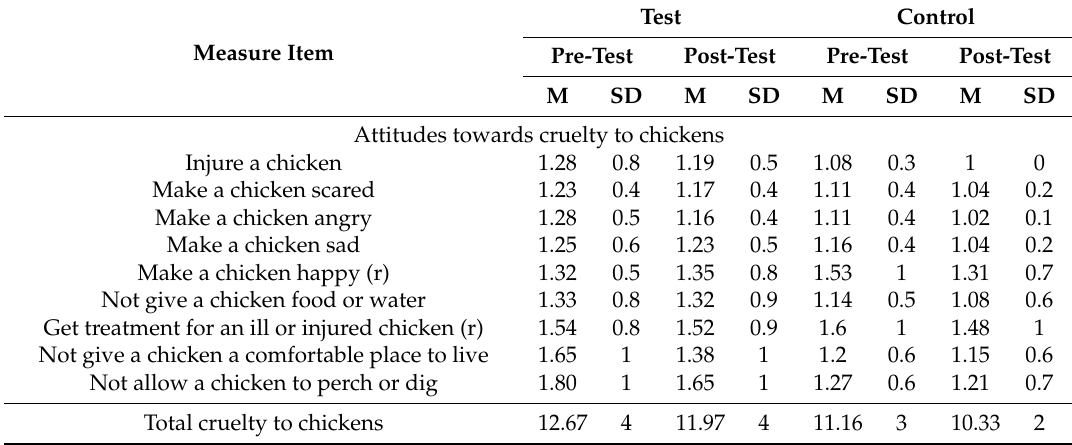
Figure 4. Children’s acceptance of cruelty to farm animals. Table 5. Descriptive statistics for children’s attitudes towards cruelty to farm animals.